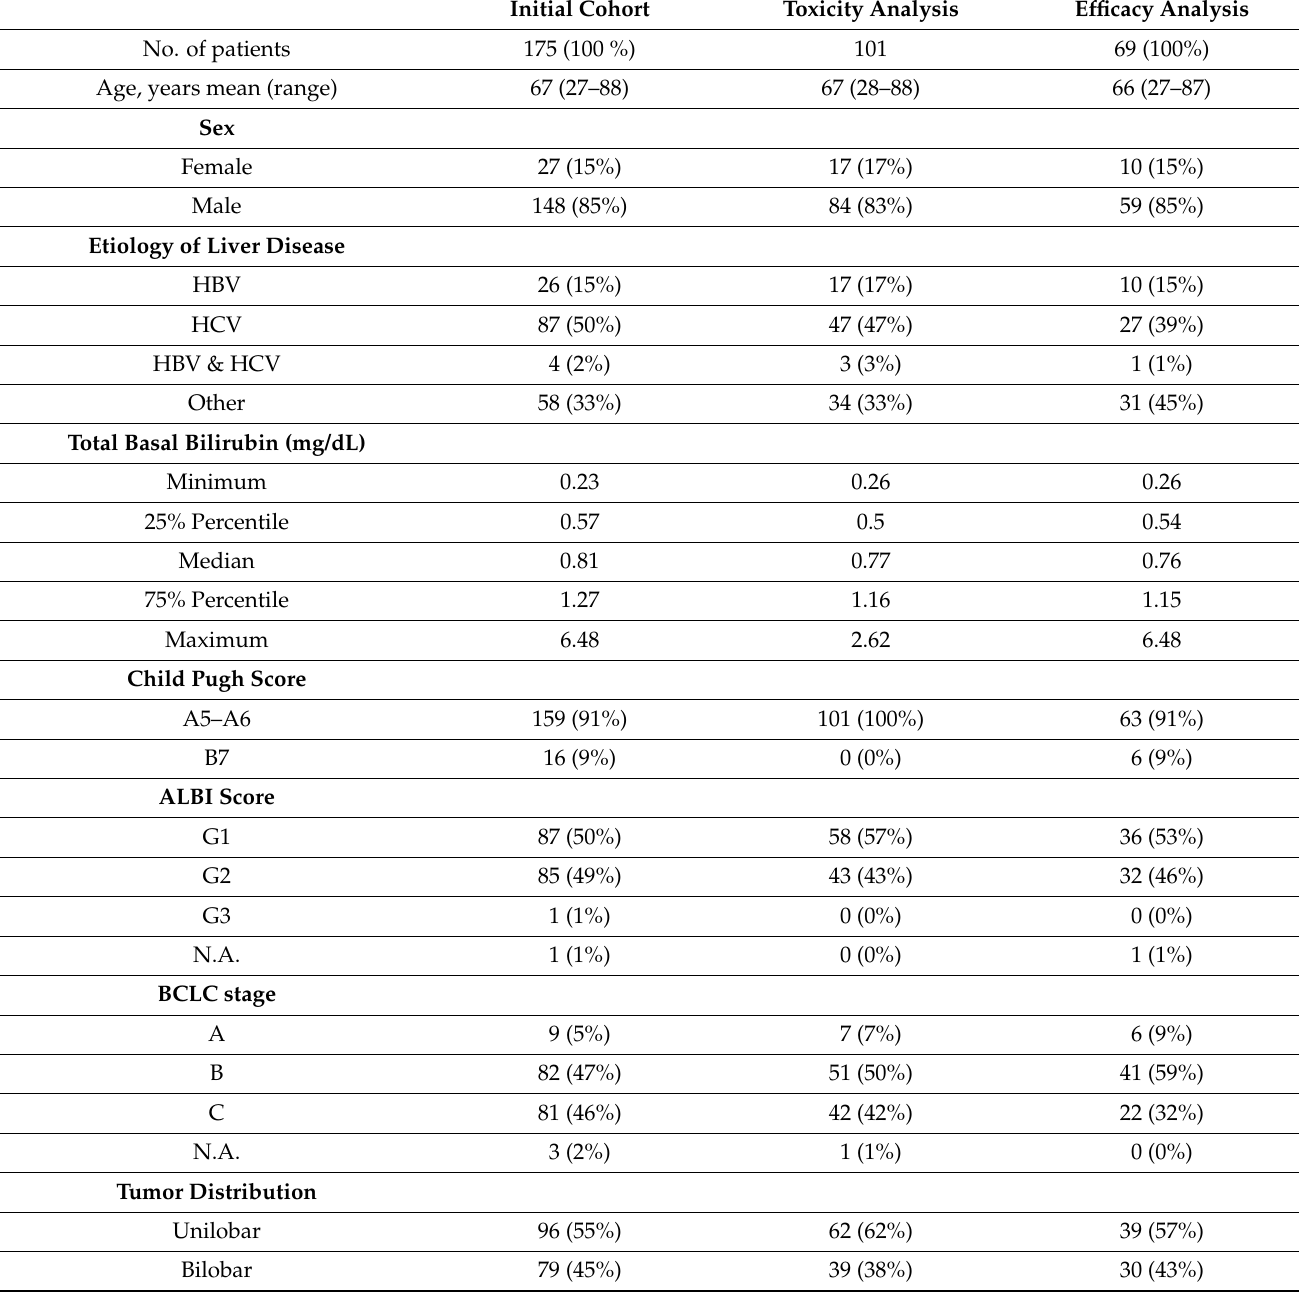
Table 1. Characteristics of the studied